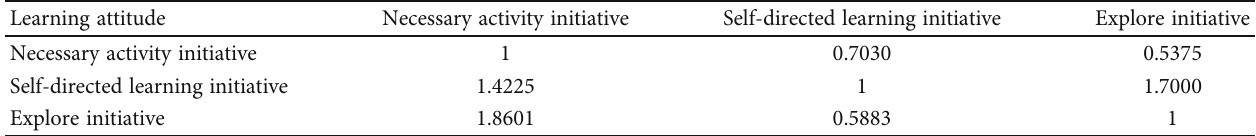
Table 1: Second-level indicator judgement matrix under learning attitude after aggregation.